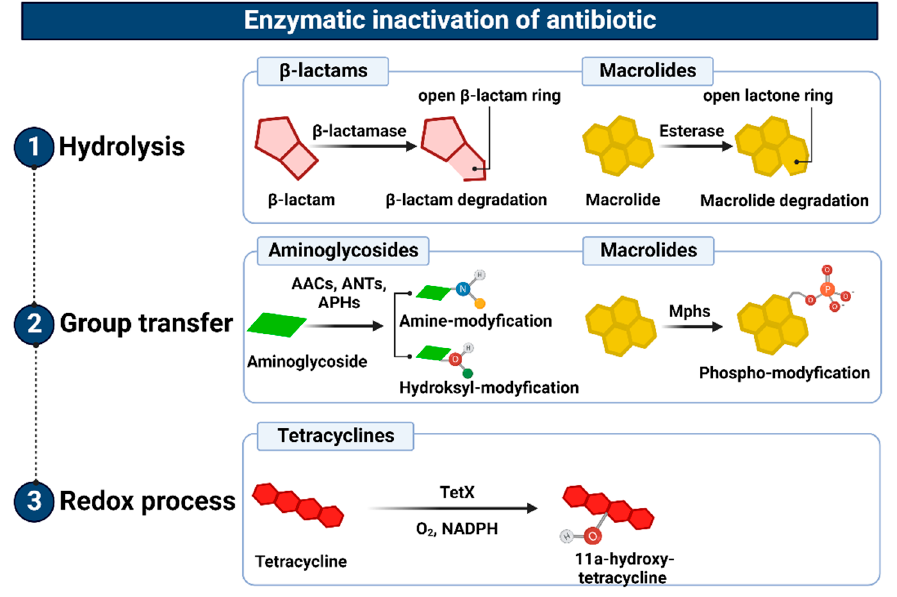
Figure 10. Representation of the enzymatic inactivation of antibiotics through ( 1 ) hydrolysis, ( 2 ) group transfer, and ( 3 ) the redox process. Figure created with Biorender.com.